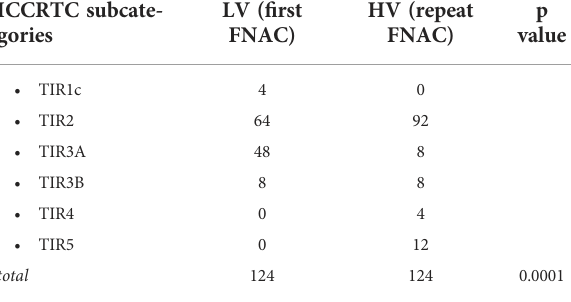
FNAC, fi ne-needle aspiration cytology; ICCRTC, Italian Consensus for the Classi fi cation and Reporting of Thyroid Cytology; LV, low-volume; HV, high-volume. Statistical signi fi cance as a p value < 0.05.